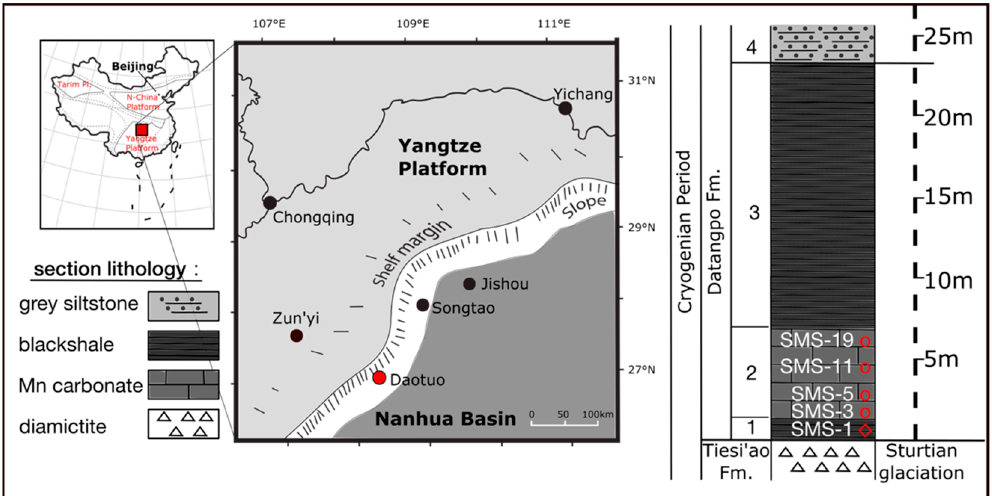
Figure 1. Paleo-geographic map of drill core locality near Daotuo, Northern Guizhou, S China, modified after Jiang et al. (2011) [70]. Stratigraphic column from Wei et al. (2016) [26]. Mn carbonate samples marked in stratigraphic profile as red circles, black shale sample is marked as a red diamond.